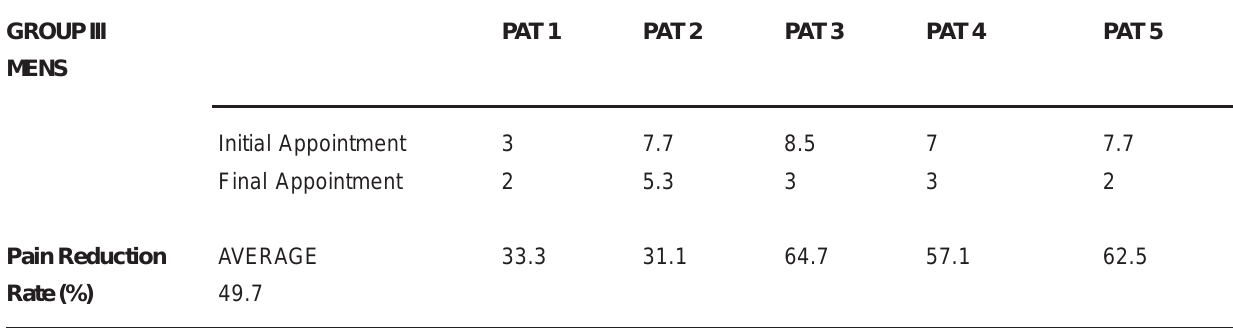
TABLE 3- Pain level of patients before and after treatment in group III (MENS) using a Visual Analogue GROUP III